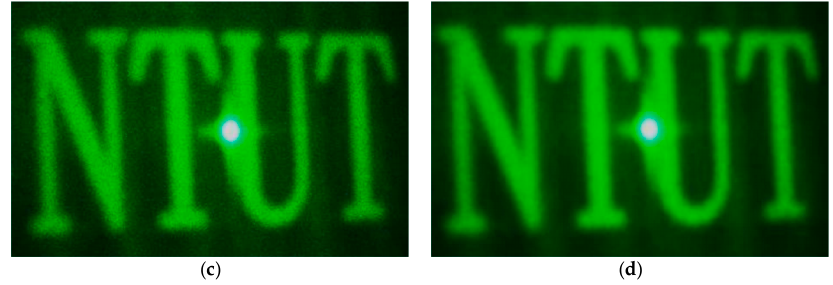
Figure 6. Resultant images of the integration of ( a ) one; ( b ) two; ( c ) four; and ( d ) eight diffractive images.